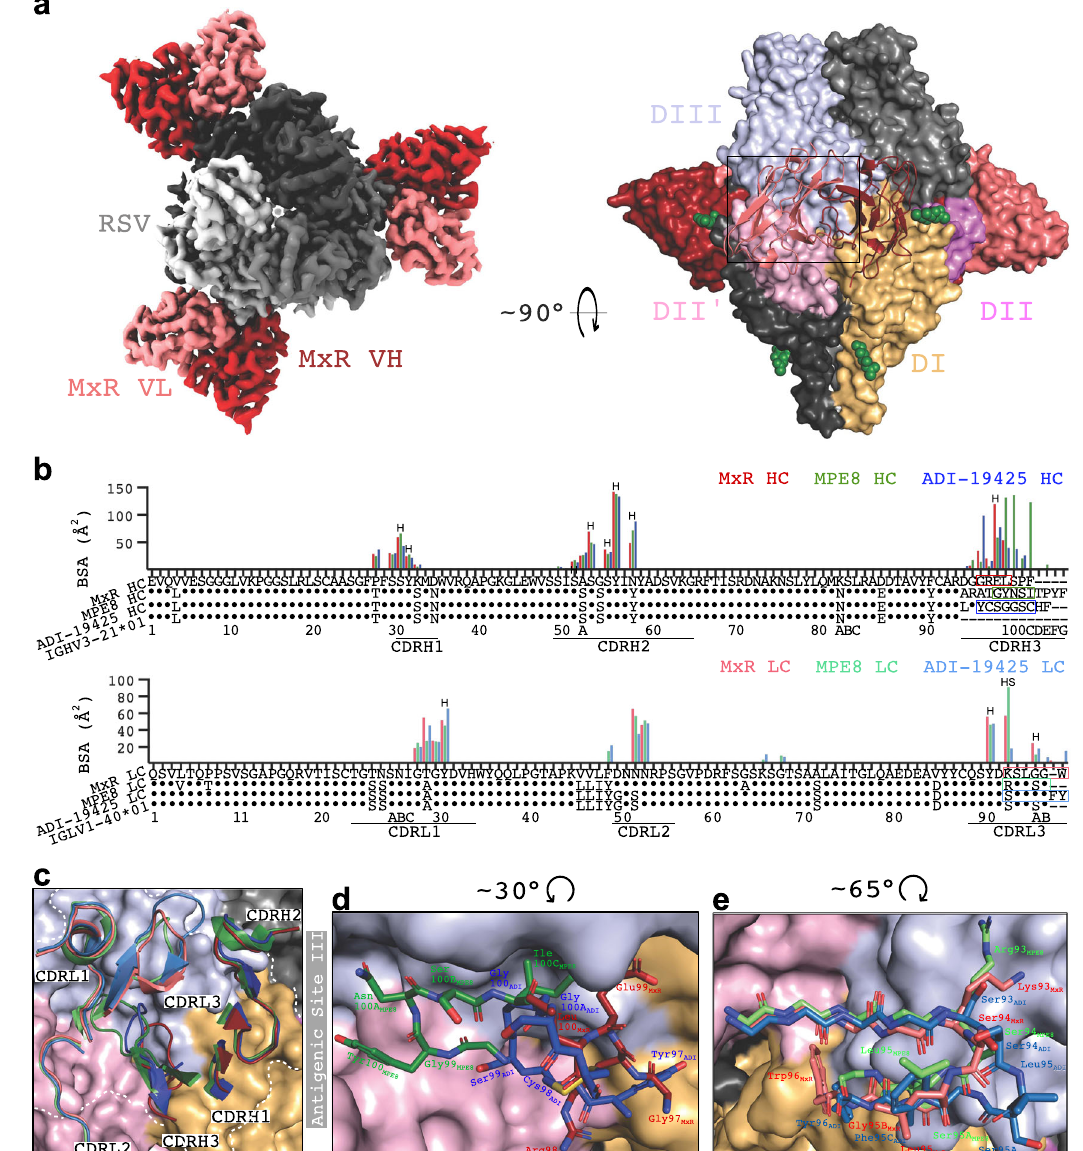
Fig. 4 | Cryo-EM structure of MxR Fab in complex with RSV preF and com- parisonwithMPE8andADI-19425.a Left,atop-downviewoftheDeepEMhanced MxR:RSV cryo-EM mapisshown, with MxRV H in darkred,MxR V L inlight red, and RSVpreFinshadesofgray.OnlytheFvdomainoftheFabisshown.Right,asurface representationofthestructureisshownrotated90°.OnepreFprotomeriscolored per its structural domains, and one MxR Fv is shown in a cartoon outline. The DII domain of the clockwise-adjacent protomer is in light pink, and designated DII ‘ to differentiateitfromDIIoftheotherprotomer,coloredinviolet.Glycansareshown as green spheres. ( b ) BSA plots for MxR, MPE8 and ADI-19425 residues which interact with RSV preF, atop a sequence alignment of the germline V-genes. The